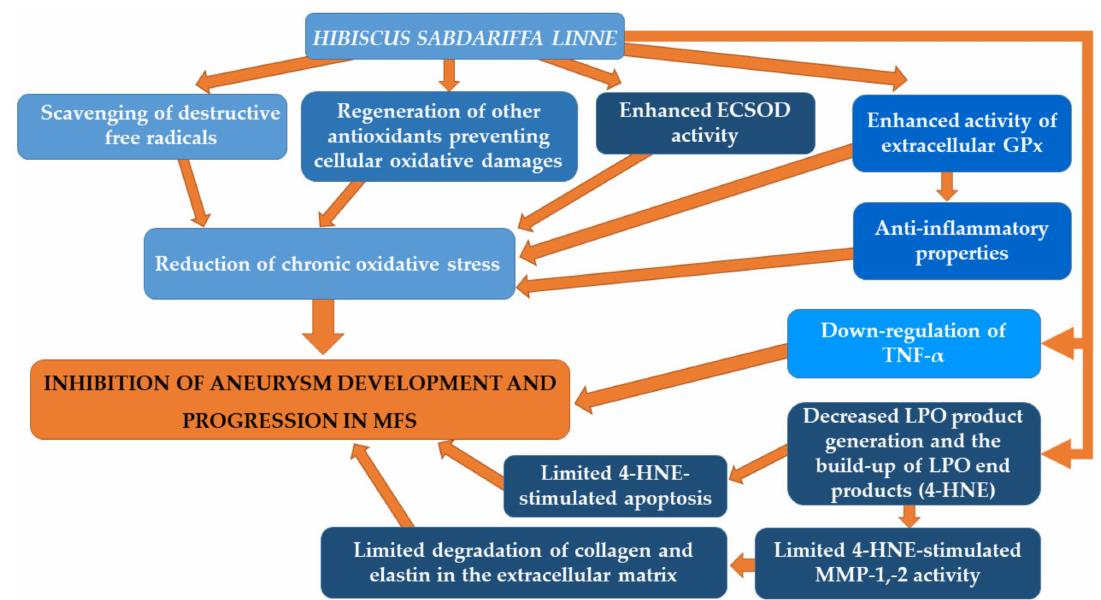
Figure 2. Plausible mechanisms underlying the beneficial effects of Hibiscus sabdariffa Linne on aortic aneurysm in